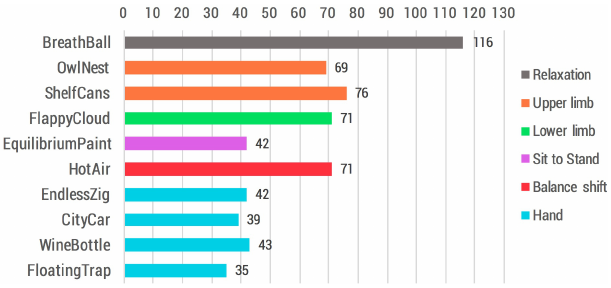
Figure 17. Classification of available serious games and frequency of use.